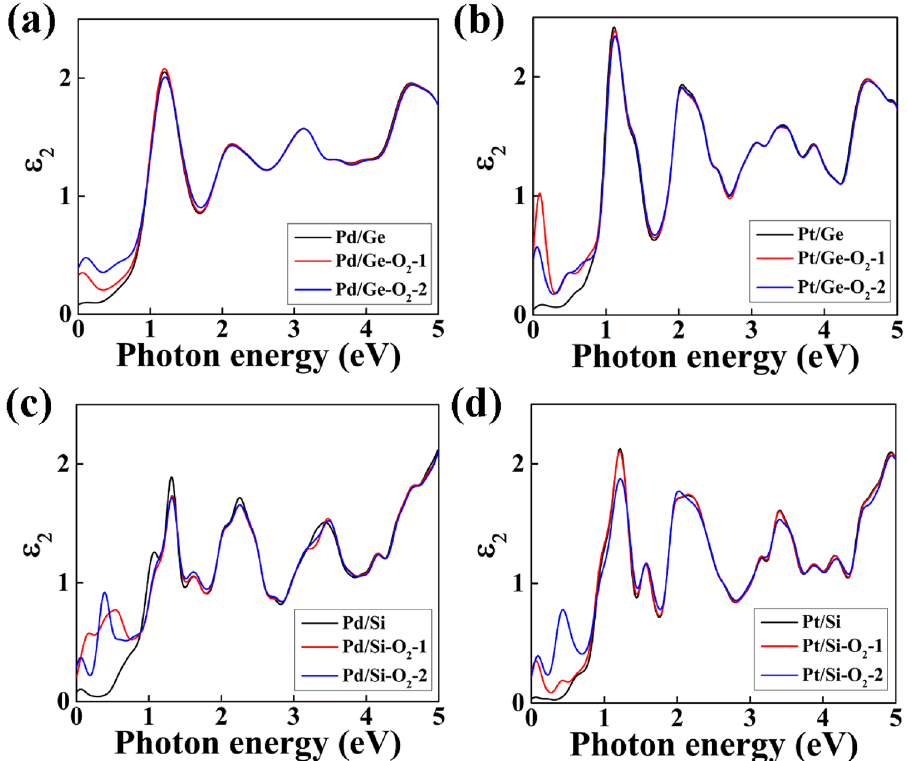
Figure 10. Variation of imaginary part ( Ɛ 2 ) of the dielectric function between the O 2 adsorbed ( a ) Pd/Ge, ( b ) Pt/Ge, ( c ) Pd/Si and ( d ) Pt/Si NW and their corresponding pure